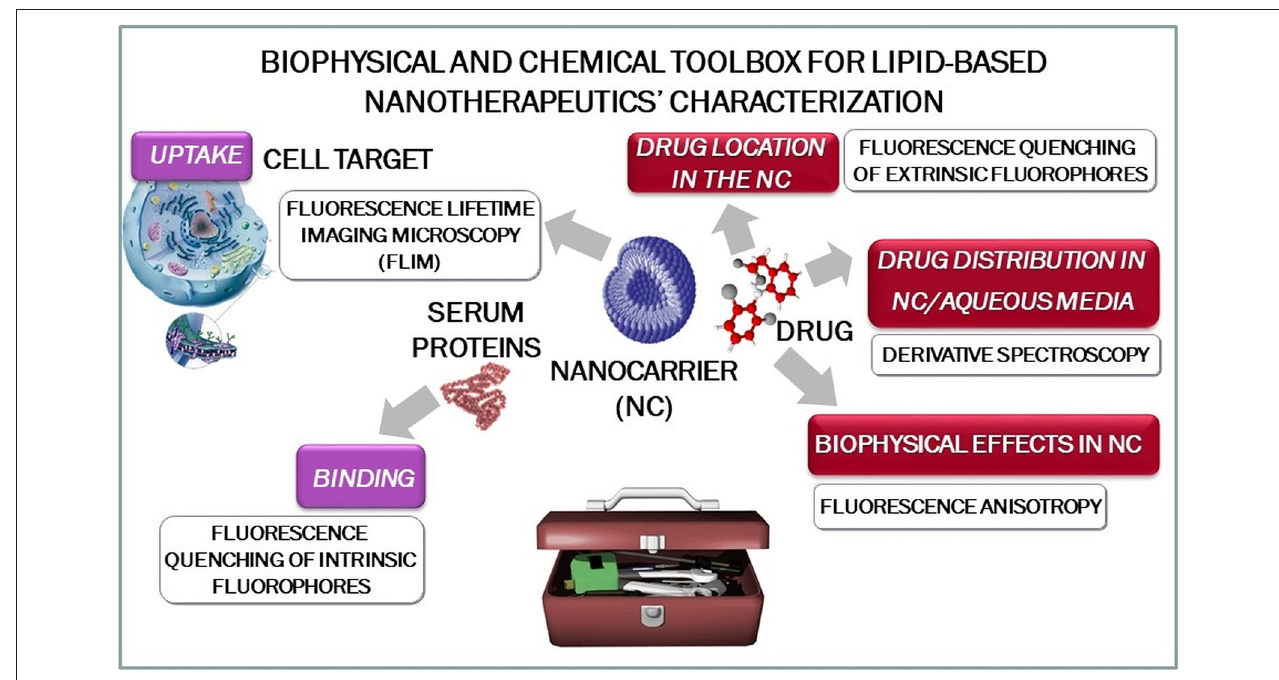
FIGURE 1 | Schematic representation of the biophysical and chemical toolbox for lipid-based nanotherapeutics’